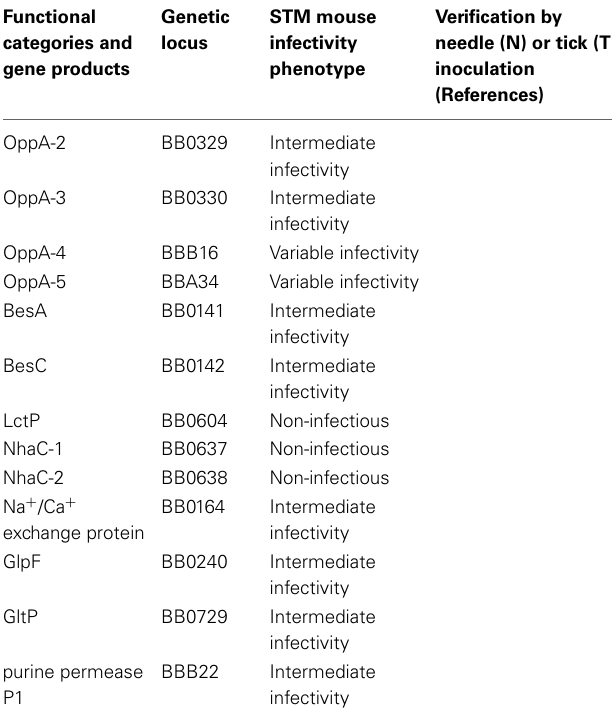
Table 2 | B. burgdorferi B31 virulence determinant candidates as indicated by STM analysis a